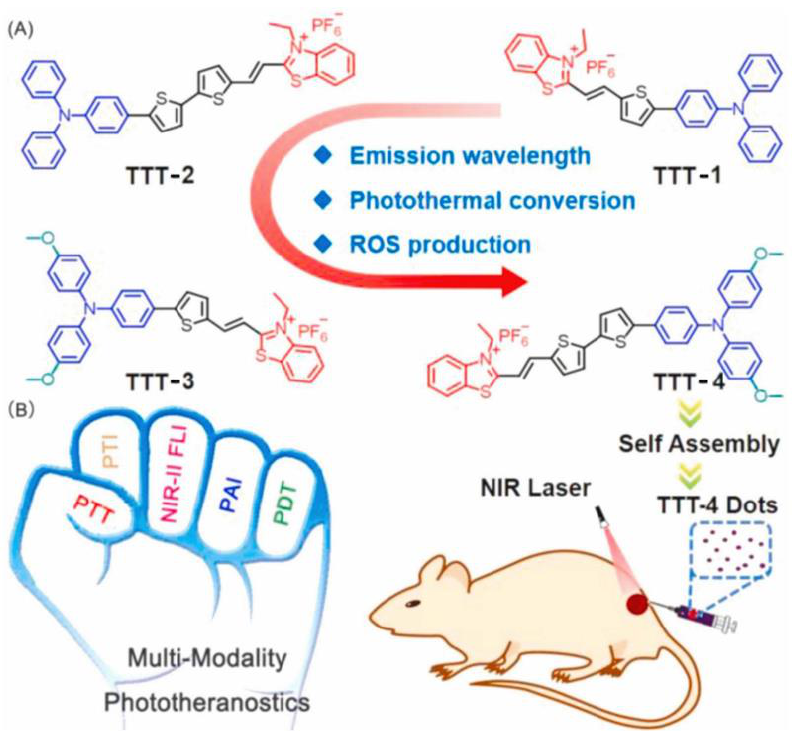
Figure 7. ( A ) Molecular structures and ( B ) multifunctional phototheranostic application of AIEgens. Reprinted with permission from Ref. [59]. Copyright 2021 Elsevier Ltd.